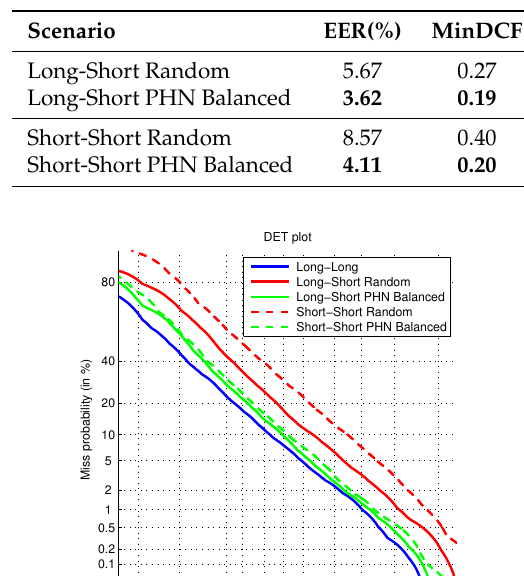
Table 2. Comparison of results, EER(%) and minDCF, between Short-Random and Short Balanced